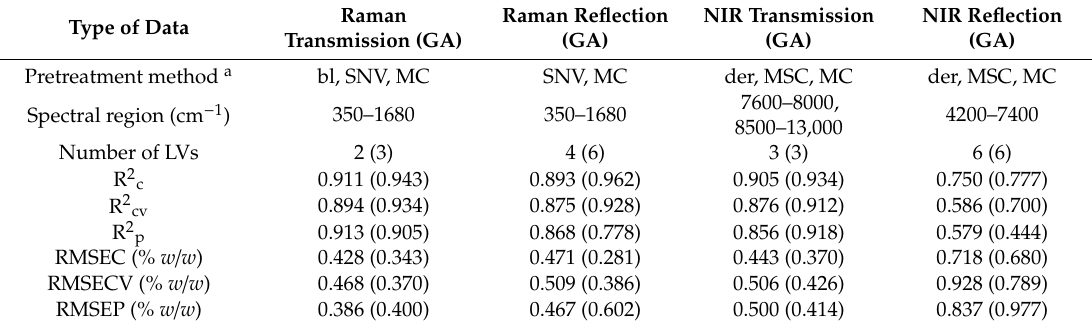
Table 2. Parameters of the models predicting DR content (models gained after genetic algorithm (GA) runs are in parentheses).